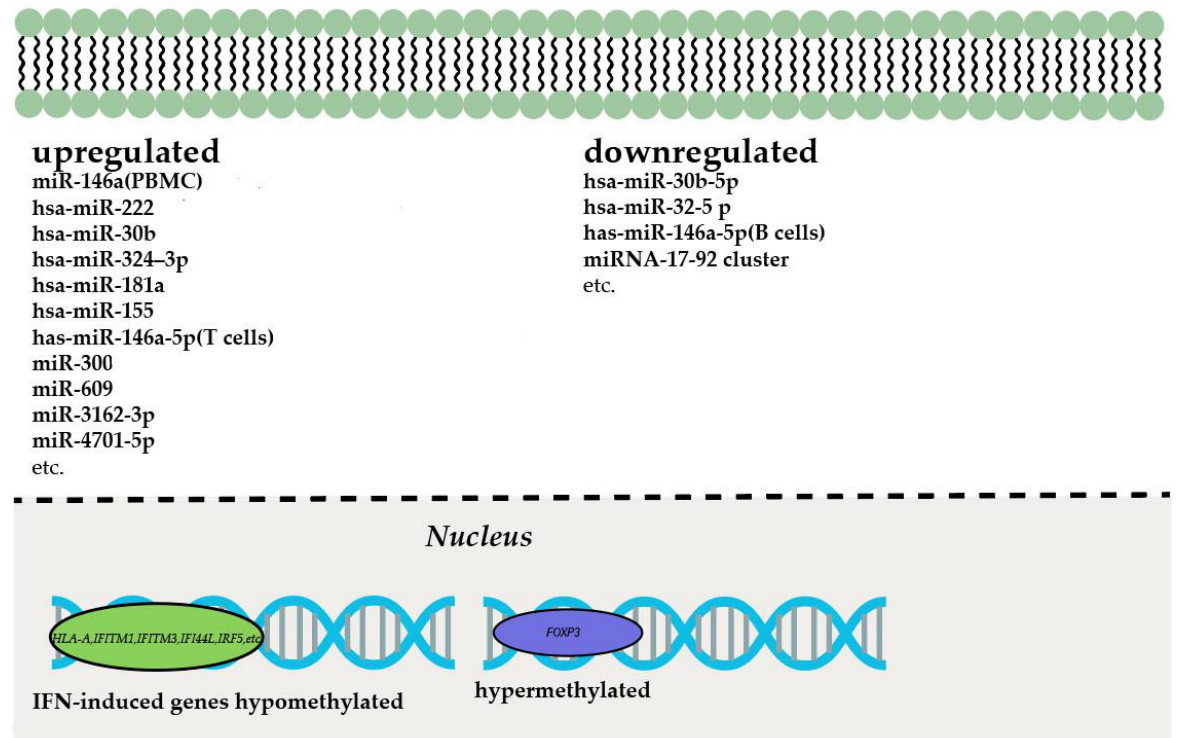
Figure 4. Epigenetic modification changes in immunocytes during SjS. IFN-related genes exhibit hypomethylation in the T and B cells of SjS patients. In addition, multiple miRNAs, correlated with IFN-related genes, are also altered in T and B cells, whereas the FOXP3 locus in Treg is hypermeth-